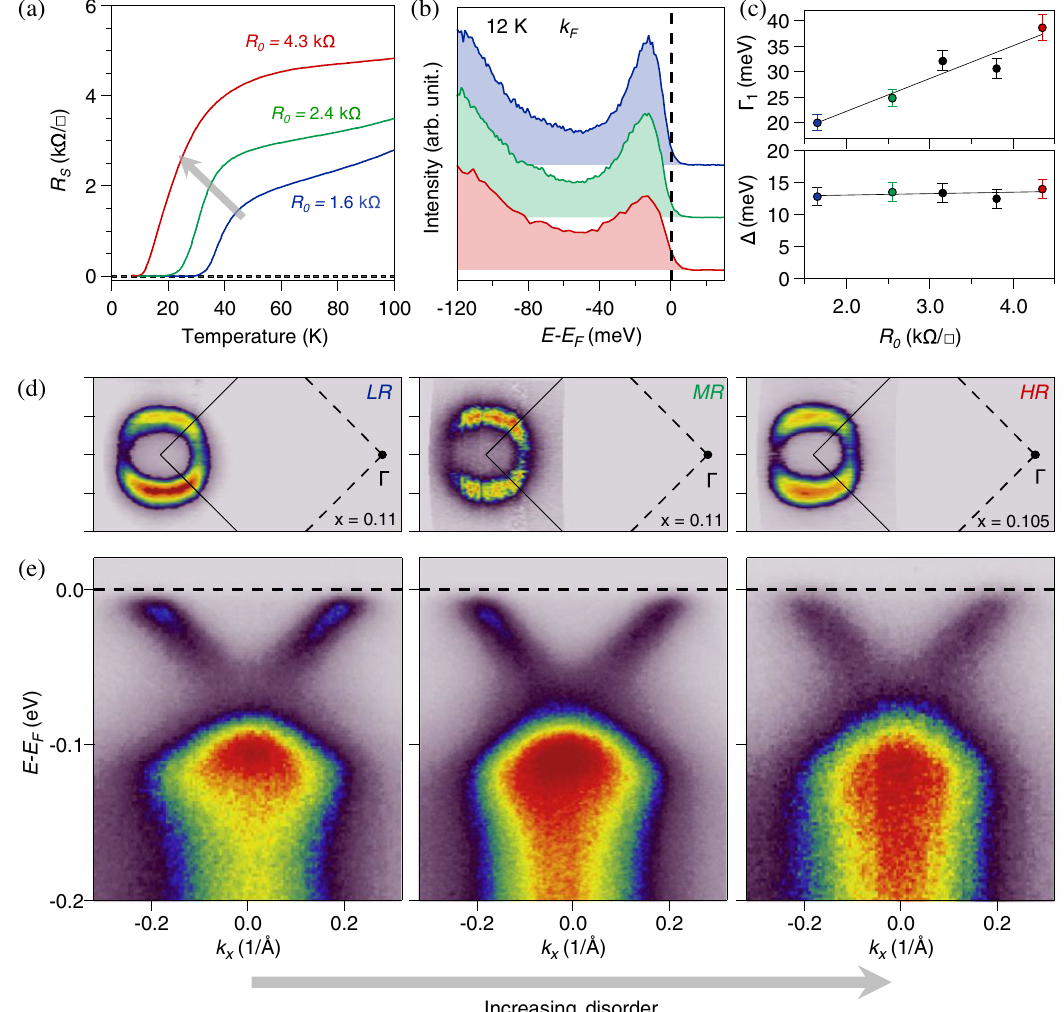
FIG. 7. Comparison of the resistive transition and ARPES band structure for films at different annealing conditions. (a) In situ R s ð T Þ measurements show that the onset of zero resistance is suppressed to lower temperatures in more resistive films. (b) Comparison of raw EDCs at k F for the same films measured in (a). (c) Comparison of quasiparticle half-width Γ 1 (top) and Δ (bottom) against residual resistance R 0 . Black markers indicate data for samples also measured by ARPES and in situ resistivity at low temperature but not presented in (a),(b). (d) Fermi surface maps and (e) high statistics cuts at M , showing minimal variation in the doping content x based on Luttinger